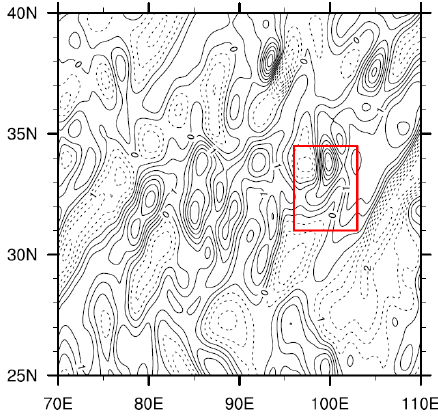
Figure 9. Divergence fields (units: 10 −5 s −1 ) at 12UTC 5 August 2014 at 200 hPa. The red box is the precipitation area.